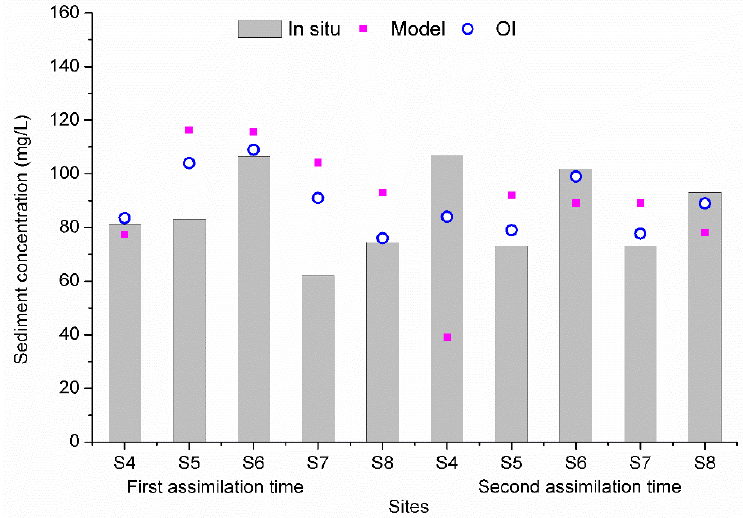
Figure 5. Surface sediment concentration from in situ , model and optimal interpolation (OI) results at all sites at the first assimilation time (13:30, on 17 October) and the